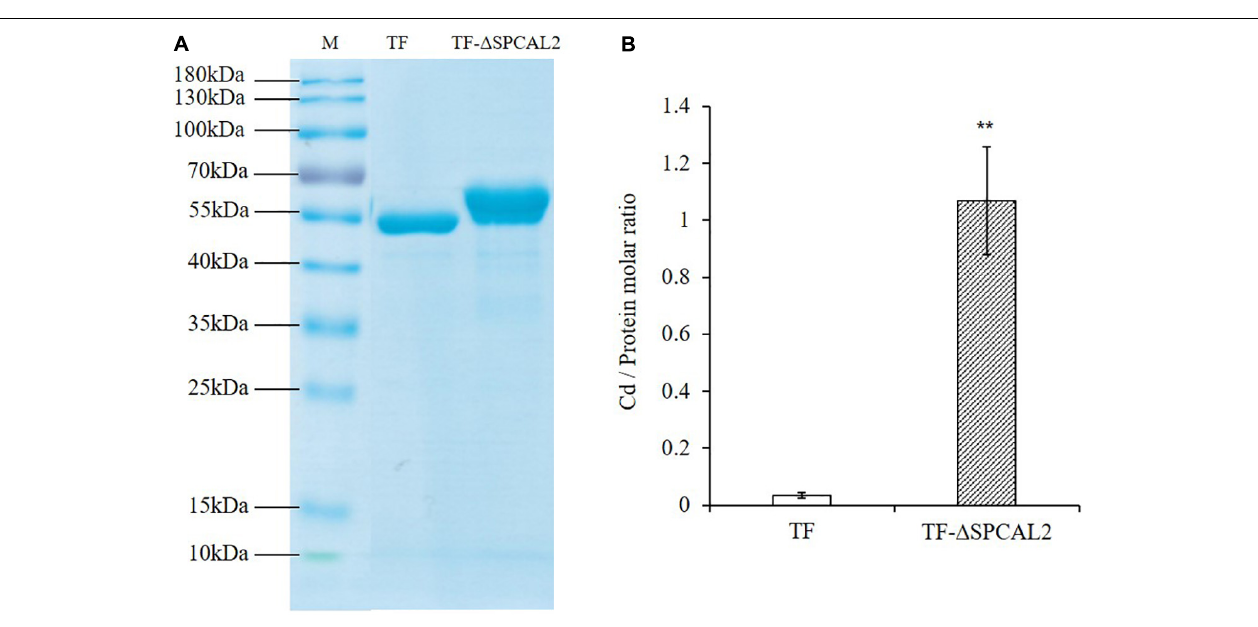
FIGURE 4 | In vitro Cd binding assay. (A) Escherichia coli trigger factor (TF) and TF fused to the N terminus of the signal peptide-deleted CAL2 (TF- (cid:49) SPCAL2) purified from E. coli . (B) The molar ratio of Cd against TF- (cid:49) SPCAL2 protein purified from E. coli cells grown with 100 µ M CdCl 2 . Data are mean ± standard deviations of three independent biological replicates. Significant differences were determined by Student’s t -test (** P < 0.01).